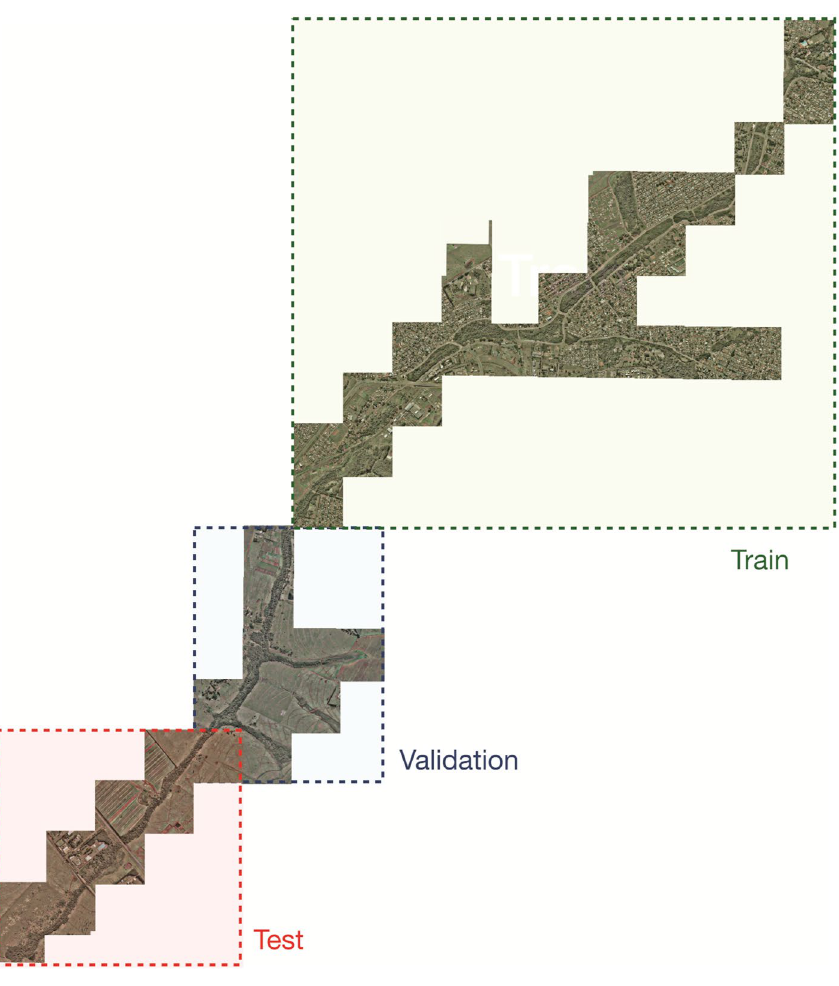
Figure 9. Training, validation, and testing datasets separated per region. Figure created with QGIS 3.16.9: https:// qgis. org/ en/ site/.